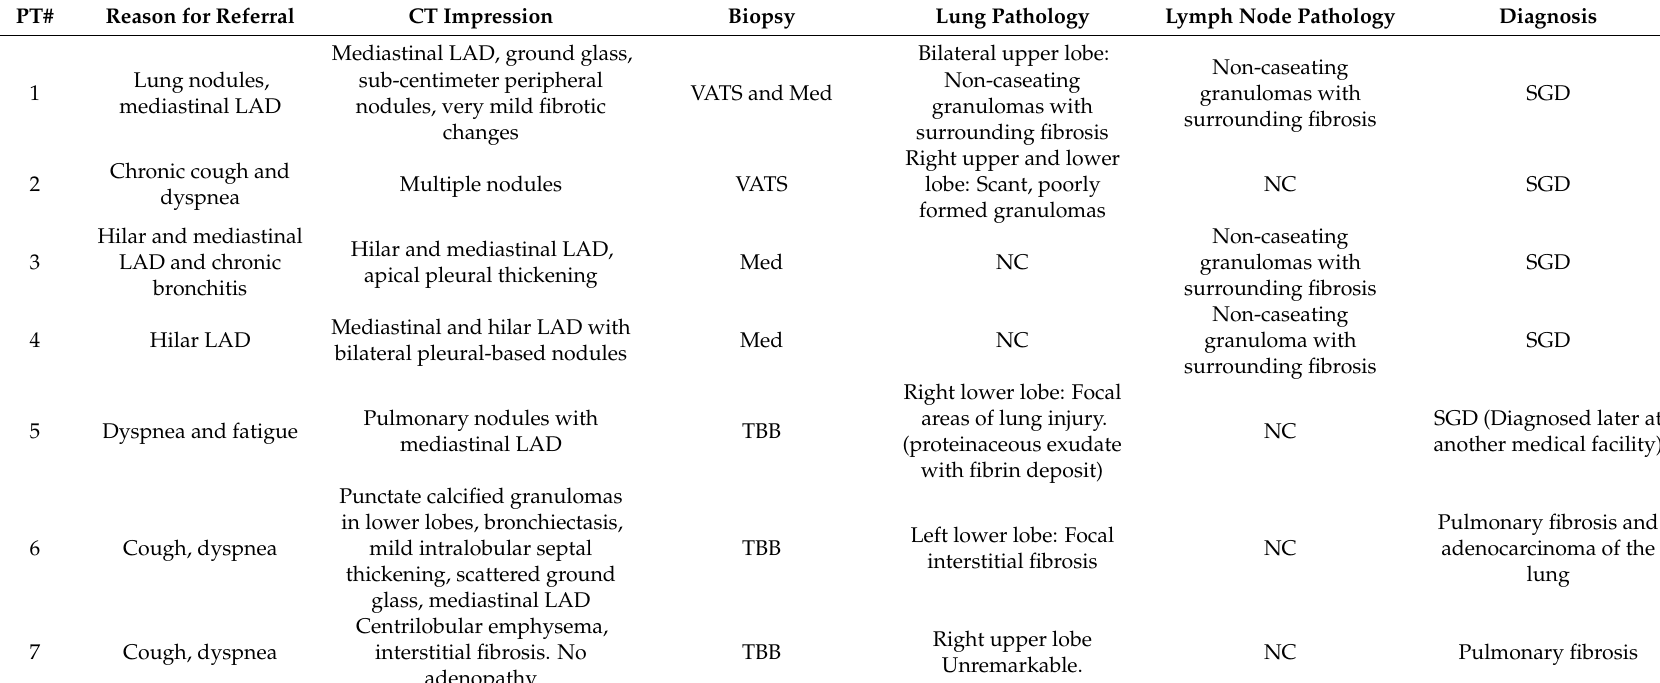
Table 2. Clinical, radiographic and pathologic presentation of